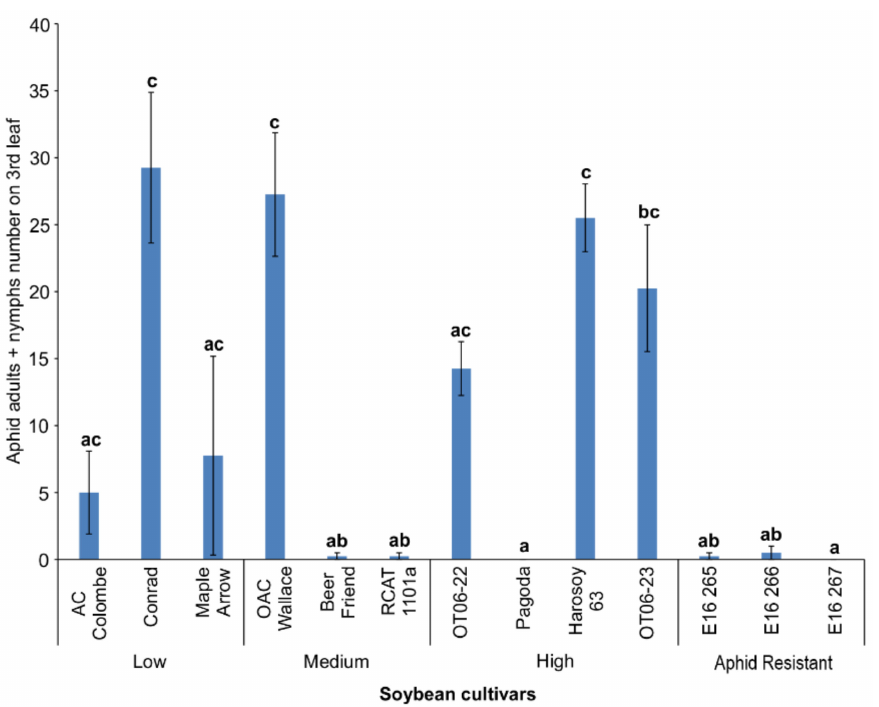
Figure 2. Mean aphid adult and nymph ( ± S.E.) counts on the 3rd full leaf of 13 soybean cultivars after 10 days of growth. Bars with the same lowercase letters indicate no significant difference ( p > 0.05) for the average aphid count between those